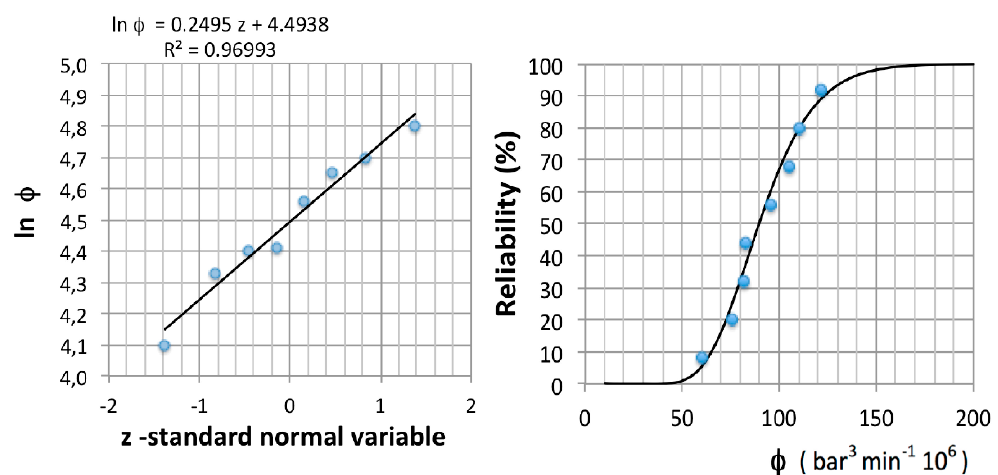
Figure 2. Statistical distribution of damage factor for k = 1 (loading task).